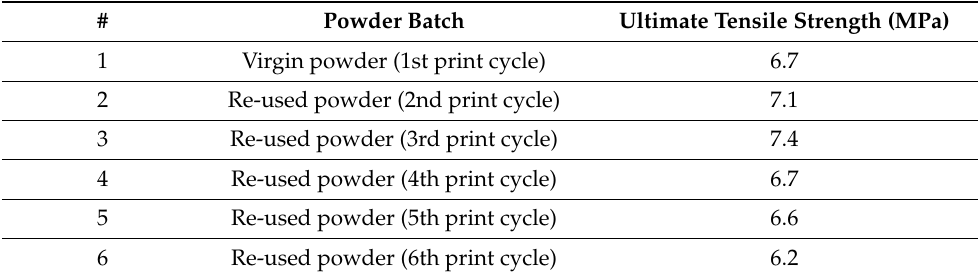
Table 10. Ultimate tensile strength of printed parts after 100% re ‐ use.